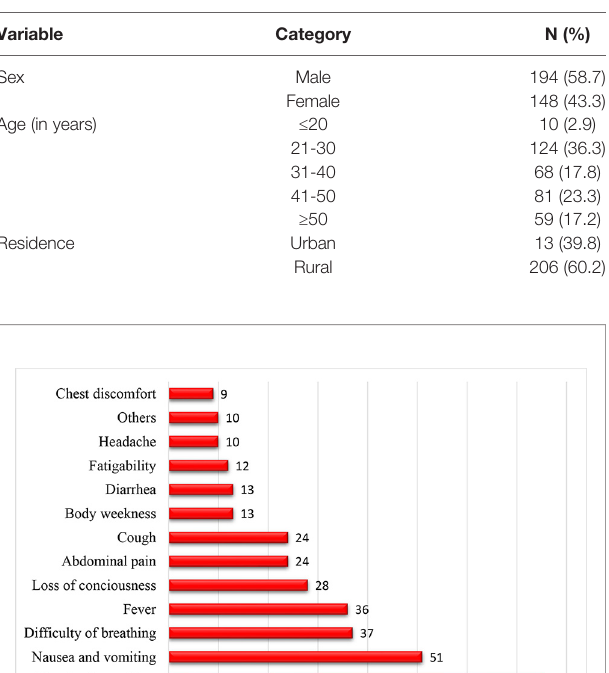
TABLE 1 | Socio-demographic characteristics of patients admitted to the emergency department of HFSUH, Harar, Ethiopia, 2018 (n = 342).